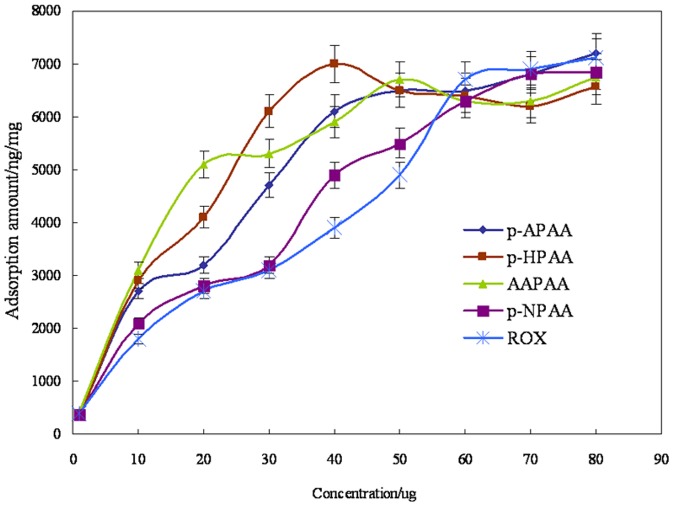
Adsorption saturation curve of CM-α-CD-Fe3O4 nanoparticles to five phenylarsonic acids.5 mg adsorbent was used for each solution. Adsorption time was 30 min. Desorption was in water for 10 min. (n = 3, with RSD<5.7%).